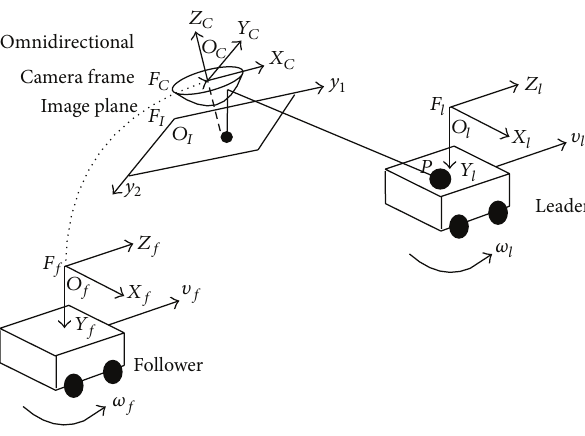
Figure 2: The projection model of omnidirectional